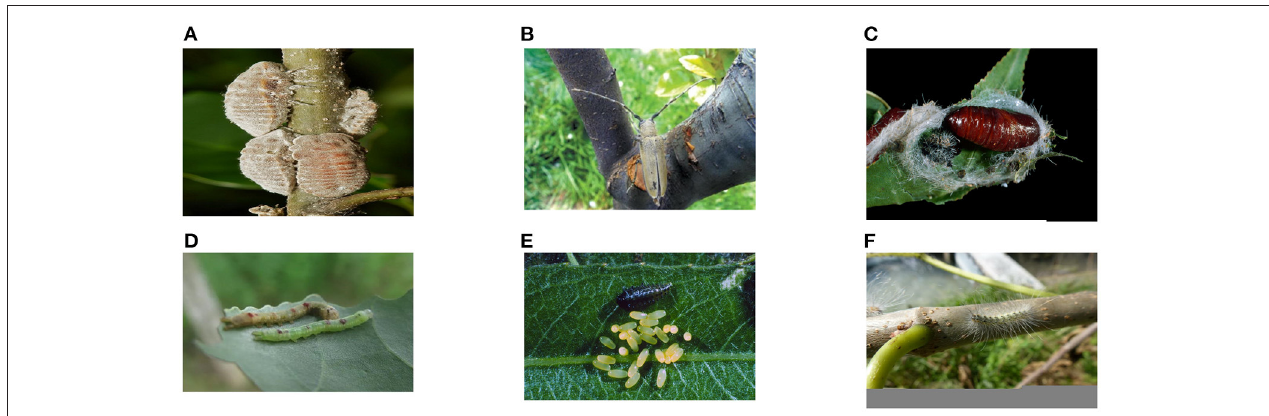
FIGURE 1 | Sample images of Forestry Pest Dataset. ( A ) Drosicha contrahens; ( B ) Apriona germari; ( C ) Hyphantria cunea; ( D ) Micromelalopha troglodyta(Graeser); ( E ) Plagiodera versicolora(Laicharting); and ( F ) Hyphantria cunea